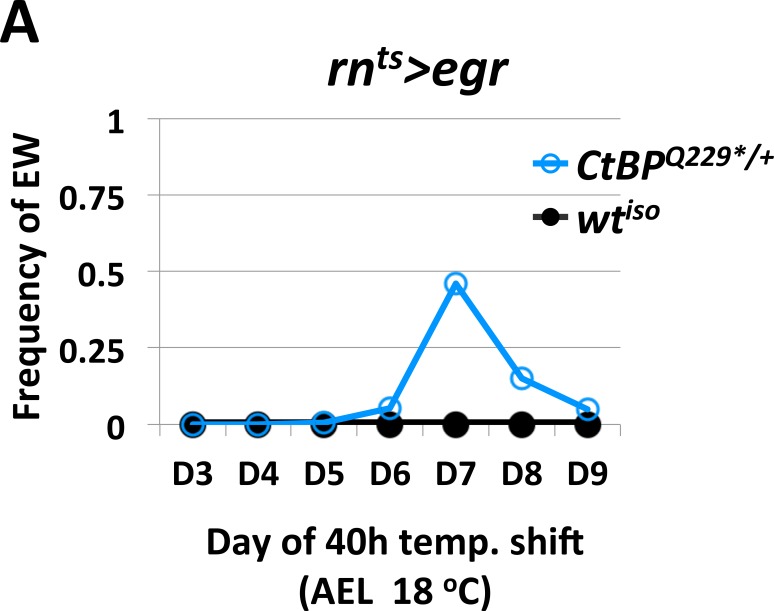
Ectopic wings occur most frequently when induced on day seven in CtBPQ229*/+.Frequency of ectopic wings (EW) following rnts>egr induced damage initiated on different days of development in wild type and CtBPQ229*/+ genetic backgrounds. The day of the upshift AEL from 18o C to 30o C is indicated.